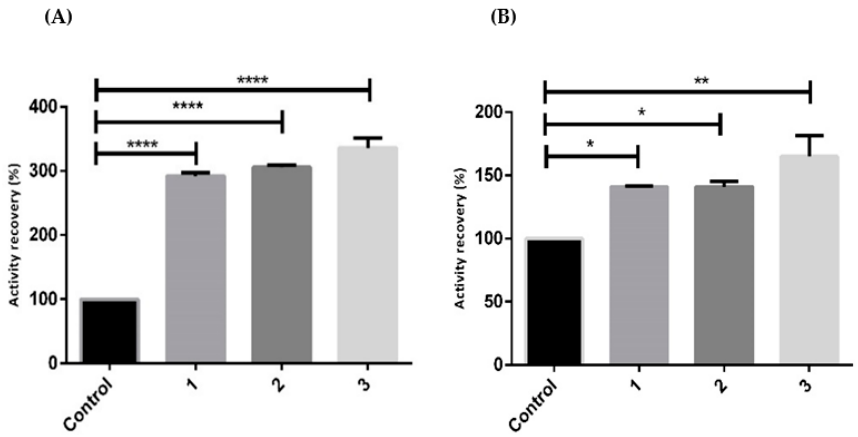
Figure 6. Percentage of hSCOMT activity recovery in the absence (control) and presence of: 1. 15 mM cysteine, 5 mM trehalose, and 5% glycerol; 2. 1 and 10 mM [Ch][DHP]; 3. 1 and 10 mM [C 4 mim]Cl during a 12 h period at ( A ) 4 °C and ( B ) − 80 °C. Each value represents the mean of 3 independent samples ( p -value * < 0.05; ** < 0.01; **** < 0.0001).